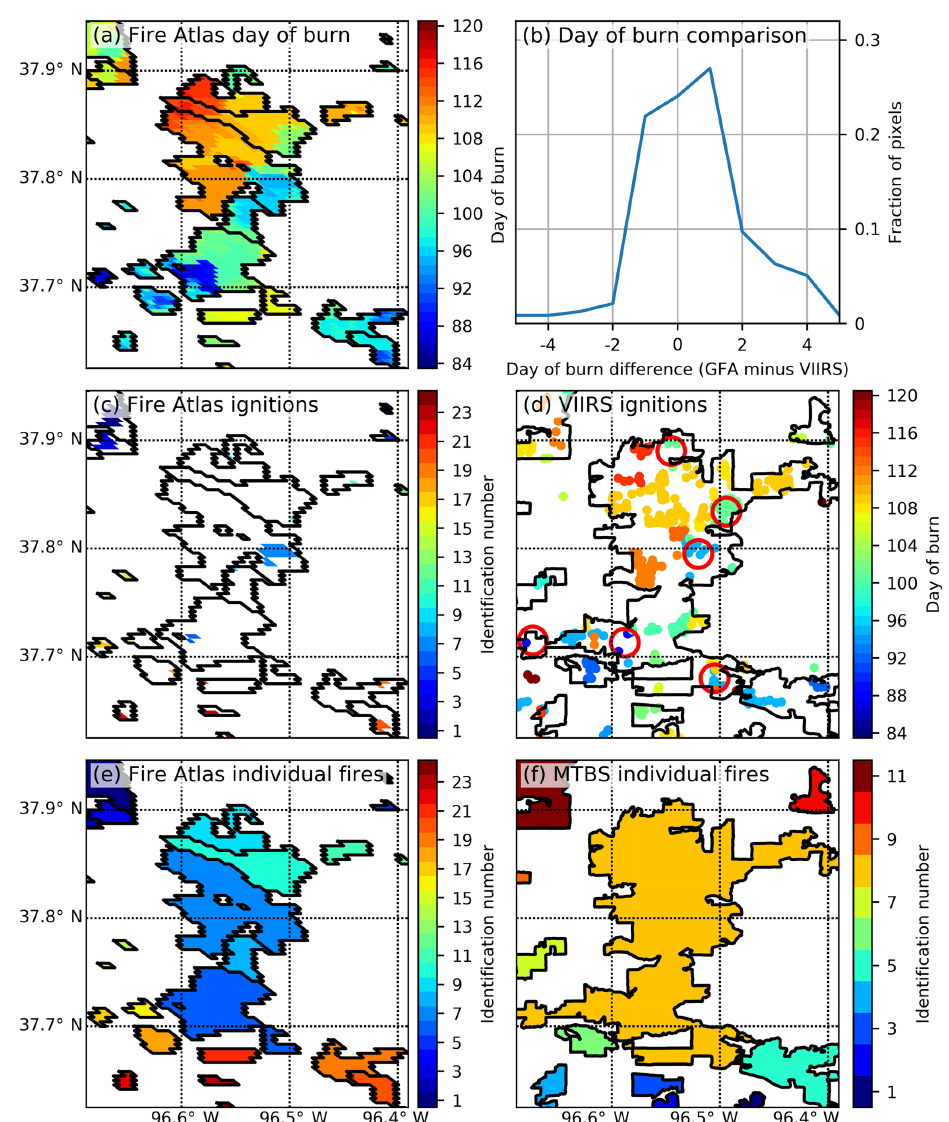
Figure B2. Comparison of Global Fire Atlas perimeters and ignition locations to estimates based on MTBS and VIIRS for frequently burning grasslands in Kansas, US. (a) Global Fire Atlas adjusted burn dates from MCD64A1, (b) per-pixel comparison of adjusted burn dates used within the Global Fire Atlas (GFA) to the day of the active-fire detection from VIIRS, (c) ignition points as estimated by the Global Fire Atlas, (d) manually interpreted ignition locations (red circles) based on VIIRS active-fire detections on top of MTBS fire perimeters, (e) individual fires as estimated by the Global Fire Atlas and (f) the MTBS burned area and individual fires. Here, MCD64A1 data underestimated the total burned area compared to the visual interpretation of Landsat data within the MTBS project, resulting in fragmentation of individual large fires. However, the daily temporal resolution of MODIS imagery allowed the Global Fire Atlas to distinguish individual fires and ignition points within larger burn scars that cannot be resolved from infrequent Landsat observations used to delineate fire perimeters within the MTBS project. Broad patterns of ignition locations identified by the Global Fire Atlas were confirmed by manual interpretation of patterns inferred from VIIRS active-fire detections (d)